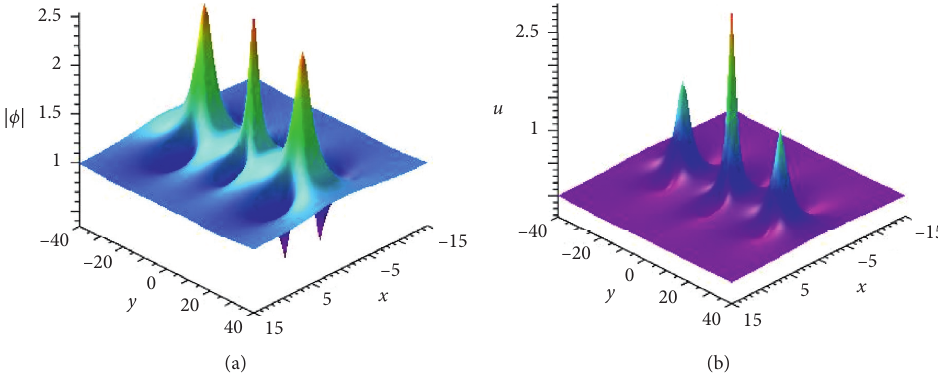
Figure 6: The third-order lump solutions | ϕ | and u defined in equation